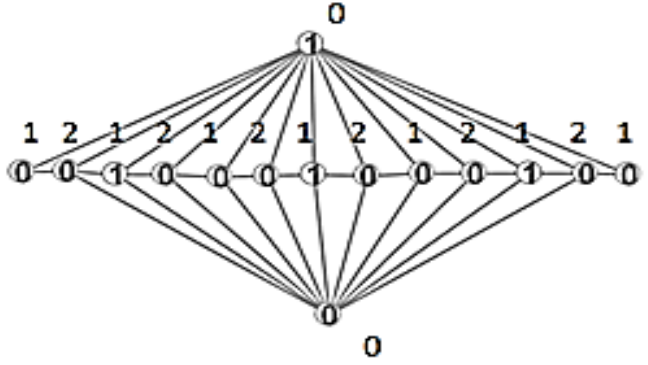
Figure 12 . Switching with modular coloring in